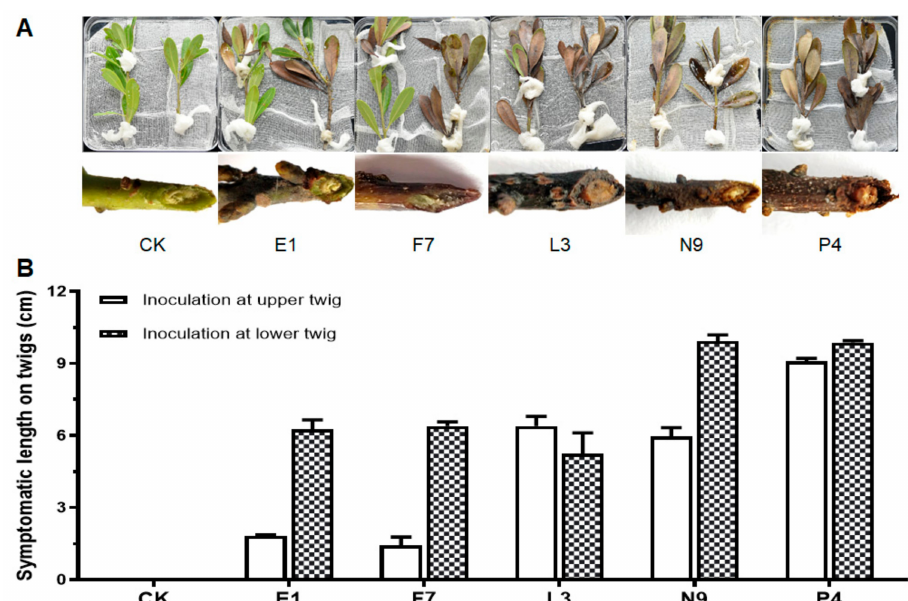
Figure 3. Pathogenicity tests of fungal isolates on detached bayberry branches. ( A ) The lesions on leaves and interior of branches caused by inoculated fungal isolates; ( B ) the symptomatic lengths on inoculated upper and lower twigs. Healthy bayberry branches collected from healthy plants (cv. Qingdi) (15–20 cm) were detached from trees and surface-sterilized. A cross was made on a branch (at the upper site or the bottom site) and a mycelial plug (5 mm in diameter) was placed onto the center of the cross with mycelia facing down. The inoculation sites of the treated branches were covered with sterile wet degreasing cotton, put in sterilized glass bottles with sterilized water, and then kept in a growth chamber with controlled conditions of 28 ± 2 ◦ C; 75% ± 15% relative humidity and 12 h white light (12,250 cd) illumination for a week. Blank PDA plugs without mycelia were used as controls (CK). The experiment was repeated in triplicates three times. Fungal isolates caused no disease symptoms were not displayed. Photos were taken after 9 days and the symptomatic length on twigs was